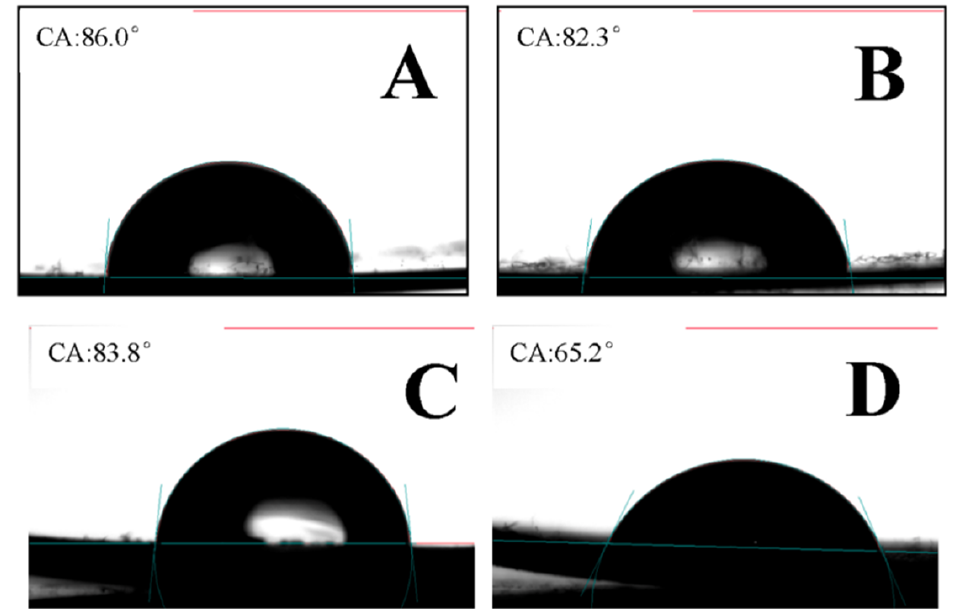
Figure 10. Contact angle test: ( A ) the blank PP sheet at 20 °C, ( B ) the blank PP sheet at 40 °C, ( C ) the sample at 20 °C, and ( D ) the sample at 40 °C (the AAm grafting degree is 101%, and the AN concentration of PP-g-P (AAm-co-AN) is 23%).